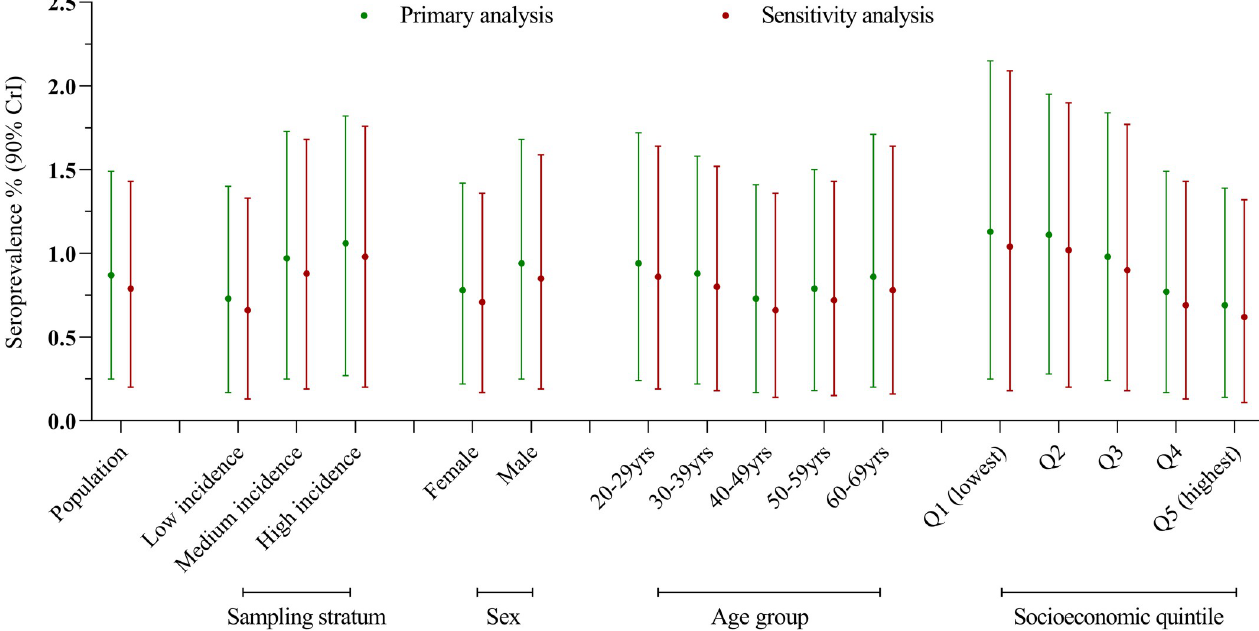
Fig 2. Estimated SARS-CoV-2 seroprevalence and 90% credible intervals (CrI) for metropolitan Melbourne blood donors aged 20–69 years. Estimation in the primary analysis assumed a uniform prior distribution for seroprevalence. Estimation in the sensitivity analysis assumed an alternative prior distribution, which focused on values for seroprevalence below 5%. Sampling strata were defined by COVID-19 case notification data to 28 October 2020: < 3 cases/1,000 population (Low incidence postcodes); 3–7 cases/1,000 population (Medium incidence postcodes); > 7 cases/1,000 population (High incidence postcodes) (S1 Table). Socioeconomic status was assigned from residential postcode based on ABS 2016 Index of relative socioeconomic disadvantage ranking within Victoria